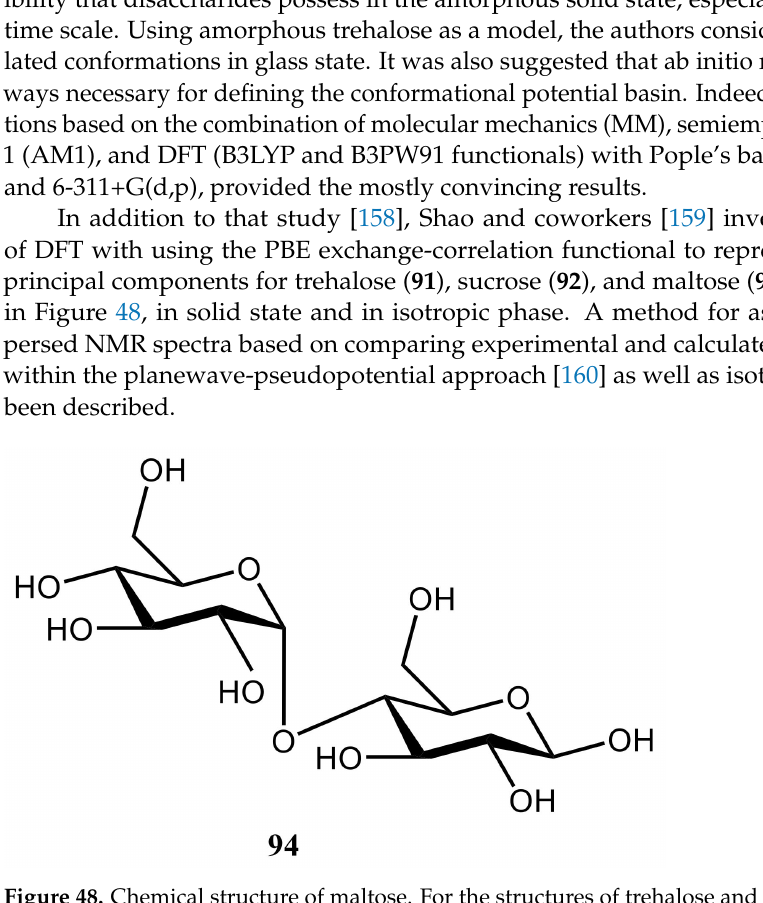
Figure 48. Chemical structure of maltose. For the structures of trehalose and sucrose, see Figure 46. Different conformations of methyl 3,6-anhydro-4- O -methyl-a-D-galactoside ( 95 ) and 3,6-anhydro-4- O -methylgalactitol ( 96 ) together with 3 (cid:48) ,4 (cid:48) -dideoxy derivatives of the α - methyl glycoside of carrabiose ( 97 ) and carrabiitol ( 98 ) are shown in Scheme 9. Those structures were reached at by the molecular mechanics and by quantum mechanical methods at the DFT level of theory using B3LYP functional with 6-31+G(d,p) basis set and at the MP2 level with 6-311++G(d,p) basis set with and without taking into account solvent effects [161]. In particular, for compound 96 , where the five-membered ring